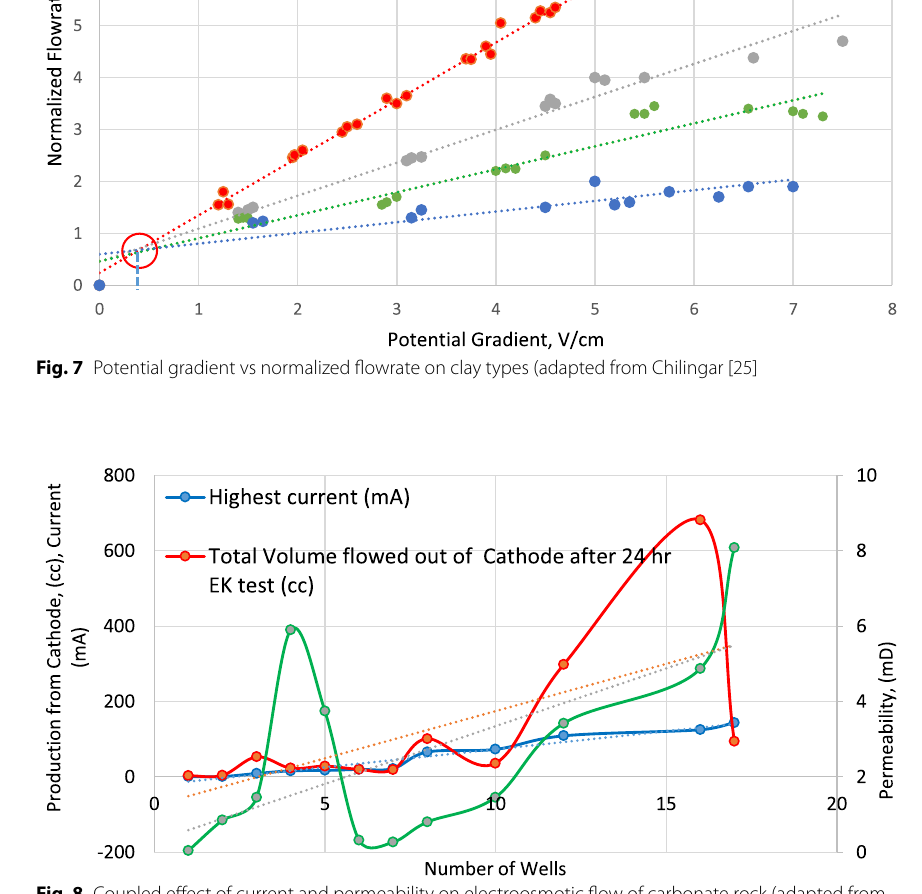
Fig. 8 Coupled effect of current and permeability on electroosmotic flow of carbonate rock (adapted from [33,